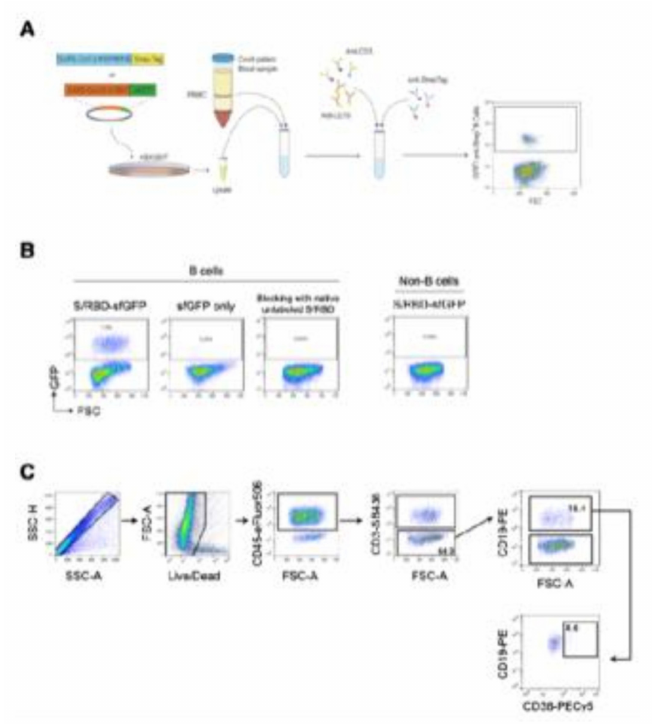
Figure 2. Schematic overview of experimental approach for the detection of B cells interacting with SARS-CoV-2 recombinant S protein by flow cytometry. ( A ) HEK-293T cells were transiently transfected with pcDNA3.1 vector, encoding the receptor binding domain (RBD) of SARS-CoV-2 protein S (spike) fused with sfGFP fluorescent marker. Afterwards, the recombinant SARS-CoV-2 protein was purified after 2 days from transfection and employed for the immunostaining of human PBMCs after red blood cell lysis. Initially, cells interacted with the recombinant SARS-CoV-2 proteins or sfGFP only as control. Subsequently after washing, cells were labelled with the reported B-cell panel of fluorophore-conjugated antibodies. ( B ) Flow cytometry plots of B cells from a representative sample after interaction with the recombinant sfGFP-tagged SARS-CoV-2 S/RBD protein, only sfGFP as control and following the blocking of binding with native unlabeled SARS-CoV-2 S/RBD protein. Plot of non-B cells from the same sample after interaction with the recombinant sfGFP- tagged SARS-CoV-2 S/RBD protein is also reported. B cells were determined in the CD19+CD3- cell fraction. Boolean gate was applied to identify non-B cells using the FlowJo (Becton Dickinson) software. ( C ) Overview of gating strategy for identifying the different B-cell subsets in peripheral blood mononuclear cells (PBMCs). Fluorescence minus one (FMO) controls were used to set up all gates. Singlets were initially discriminated on SSC-H and SSC-A, followed by the exclusion of non-viable cells with Live/Dead far-red fluorescent DNA dye and the identification of CD45+ cell fraction. B cells were identified as CD3-CD19+ and plasma B cells were differentiated as CD38 high within the subset of B